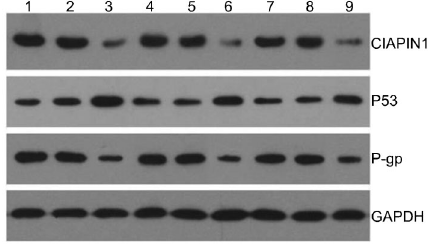
Figure 2. Expression of CIAPIN1, P53, and P-gp protein in each group by Western blot. Lanes 1 , 4 , 7 , blank control; lanes 2 , 5 , 8 , ADM group; lanes 3 , 6 , 9 : RNAi-ADM group.